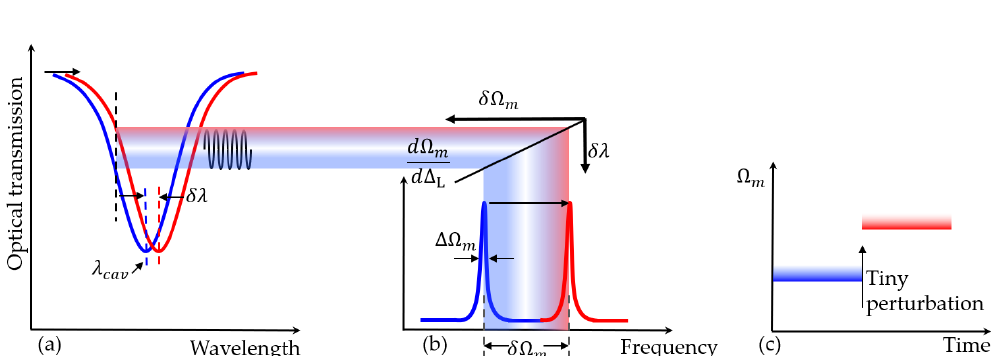
Figure 14. Schematic illustrating optical spring sensing mechanism [108]: ( a ) optical transmission spectrum; ( b ) and ( c ) mechanical spectra shift due to the applied tiny perturbation.